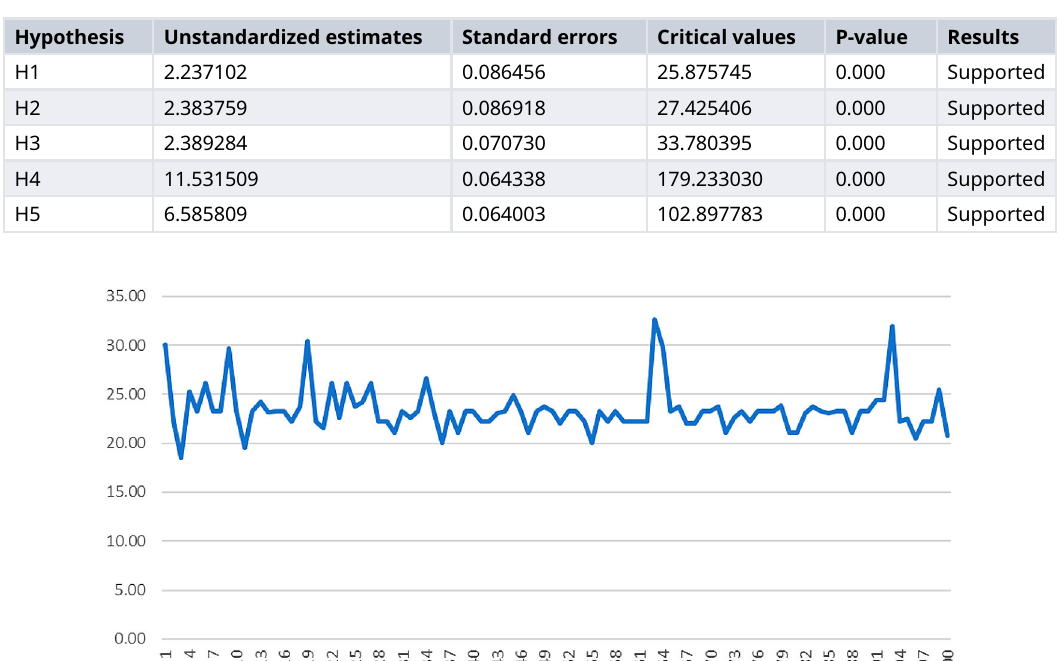
Figure 3. Motivating potential score of AML